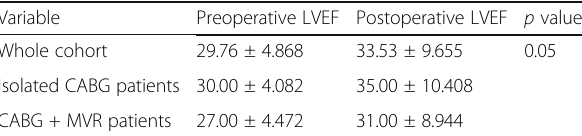
Table 4 Change in LVEF after CABG Variable Preoperative LVEF Postoperative LVEF p value